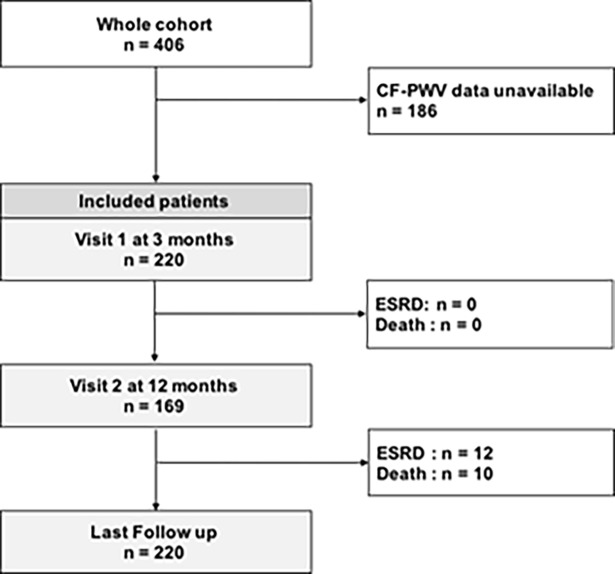
Study flow charts.